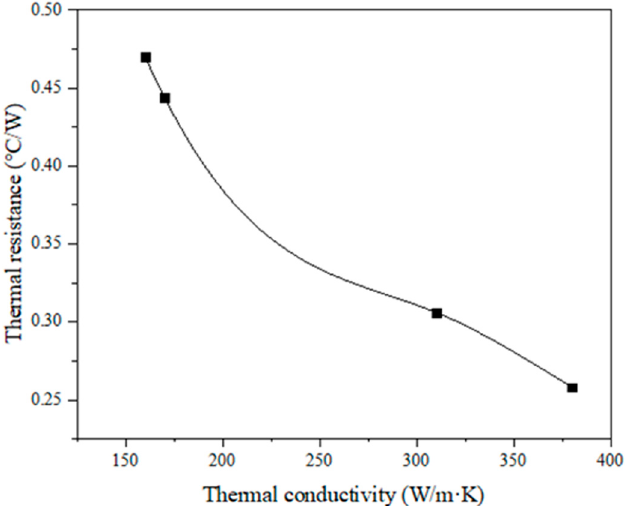
Figure 17. Thermal resistance varies with thermal conductivity of microchannel